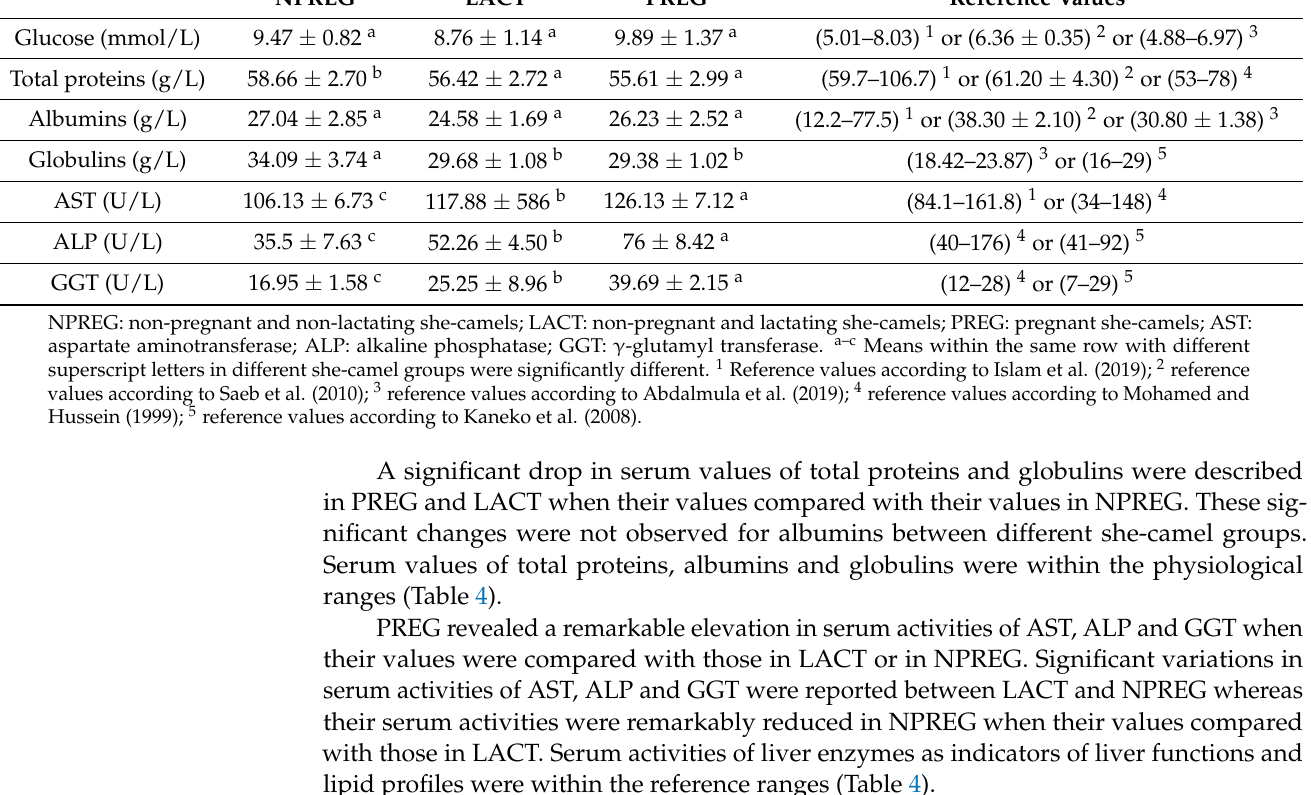
Table 4. Mean values (M ± SD) of liver functions and lipid profiles indices in non-pregnant non-lactating ( n = 14), non-pregnant lactating ( n = 8) and pregnant ( n = 38) she-camels. NPREG LACT PREG Reference Values Glucose